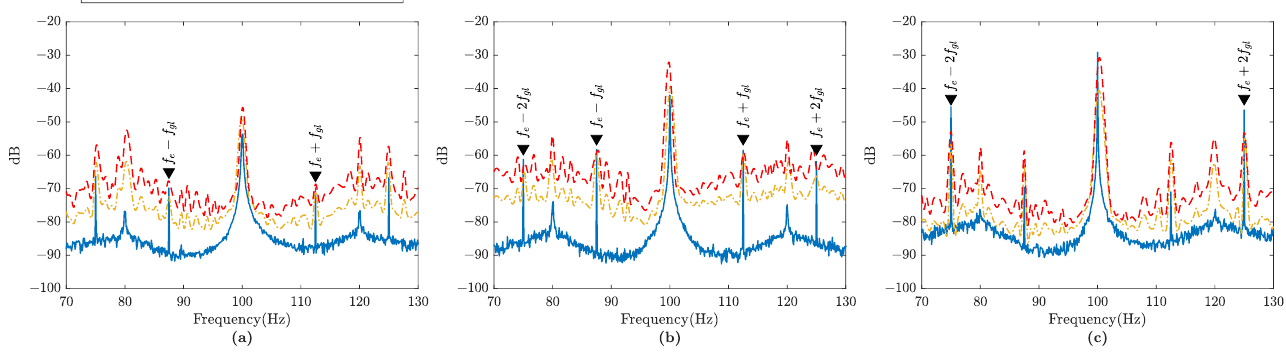
Figure 8. Gear-to-gear fault residual current spectrum: ( a ) slightly worn damage at a tooth of the driven gear; ( b ) severely worn damage along a tooth of the driven gear; ( c ) no lubricant at both the driving and driven